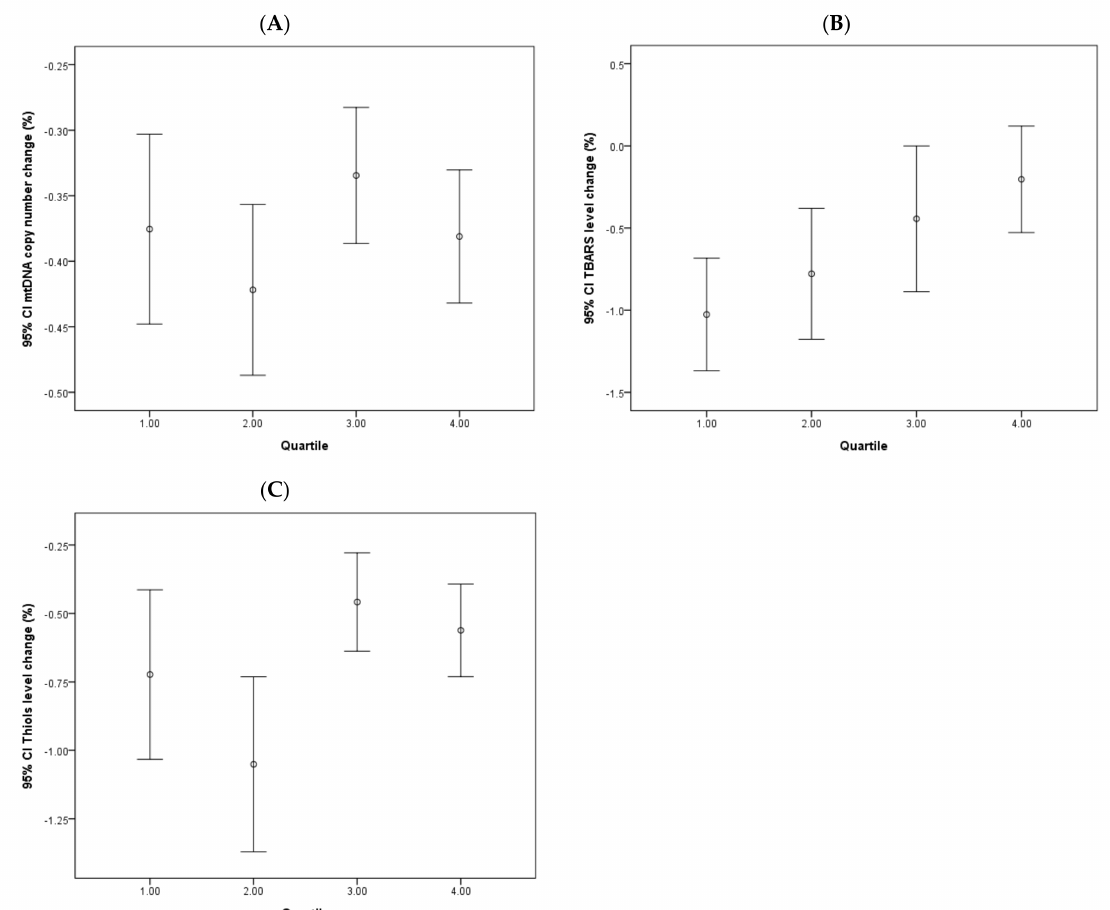
Figure 4. Changes of continuous dopamine administration on various oxidative stress markers and mtDNA copy number in PD patients. Error bar plots show levels of average Log ∆ Ct copy number ( A ), TBARS ( B ), and thiols ( C ) in di ff erent quartile subgroups of dopamine dose in PD